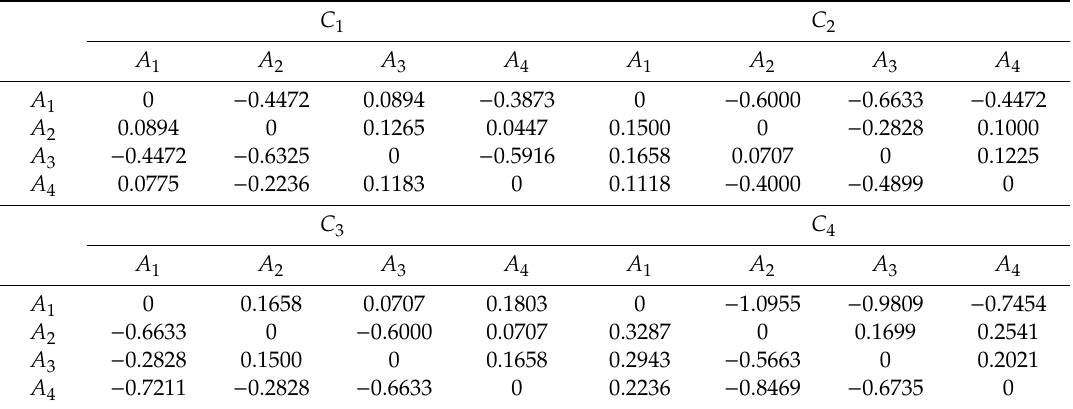
Table 7. Gains and losses of judgment debtor A i over judgment debtor A k under di ff erent attributes C j . C 1 C 2